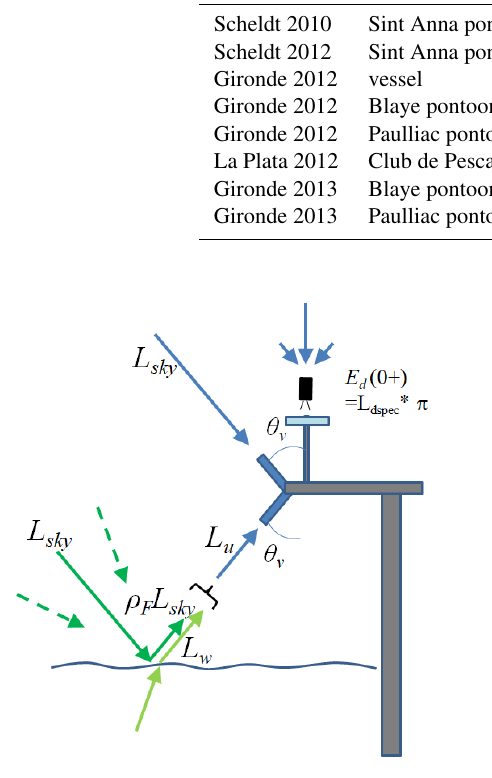
Figure 2. Instrument setup for E d (0 + ) measurement.